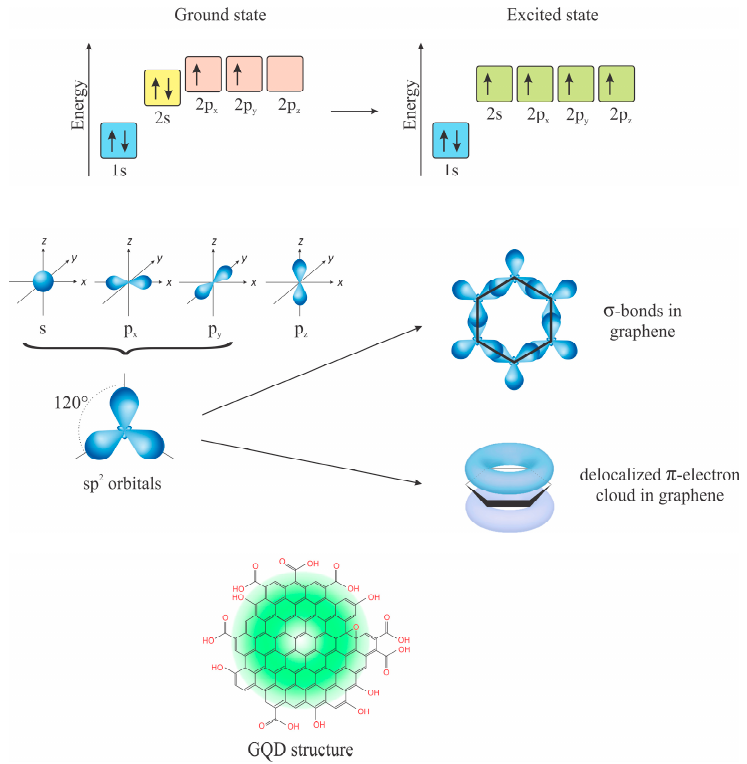
Figure 4. Electronic configuration of C atom, hybridization, and electronic cloud in benzene rings, and the electronic cloud in GQDs.